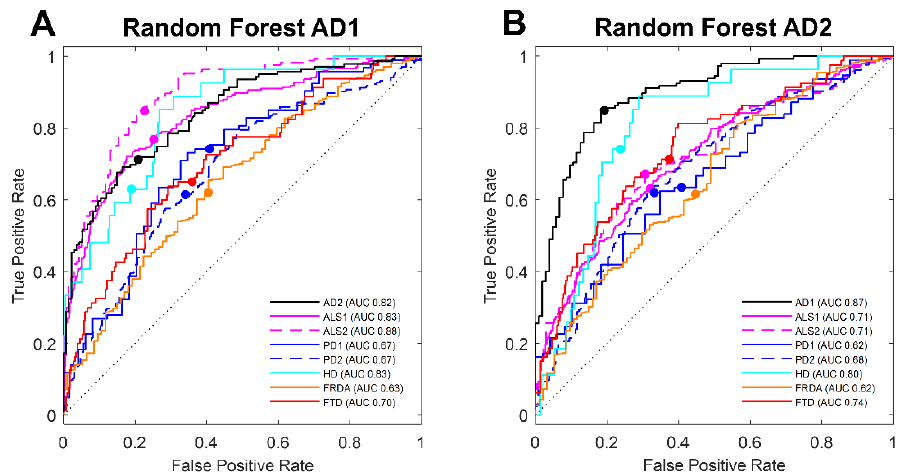
Figure 3. Linear discriminant analysis (LDA) of random forest-selected transcripts from AD whole blood gene expression data. ROC curves generated from discriminant scores of LDA on the top 20 Table 63060. AD1 model #55 with sensitivity 78% (left) and training on (B) GSE63061 AD2 model #24 with sensitivity 87% (right). Each line color denotes a specific neurodegenerative disease tested using transcripts selected for AD1 ( A ) or AD2 ( B ). Points on lines mark LDA-selected threshold for each test. ROC curve line color: AD (black), HD (cyan), FRDA (orange), PD (blue), ALS (pink), and FTD (red). AUC: area under curve probability for predicting classification of disease.